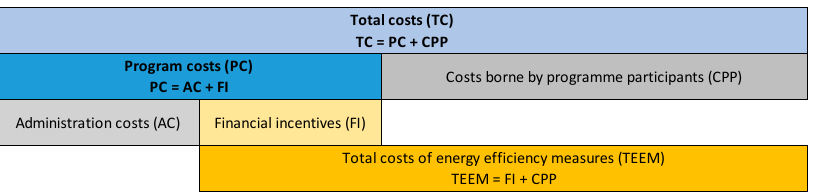
Figure 1. Types of costs considered when evaluating energy efficiency programmes (EEPs).